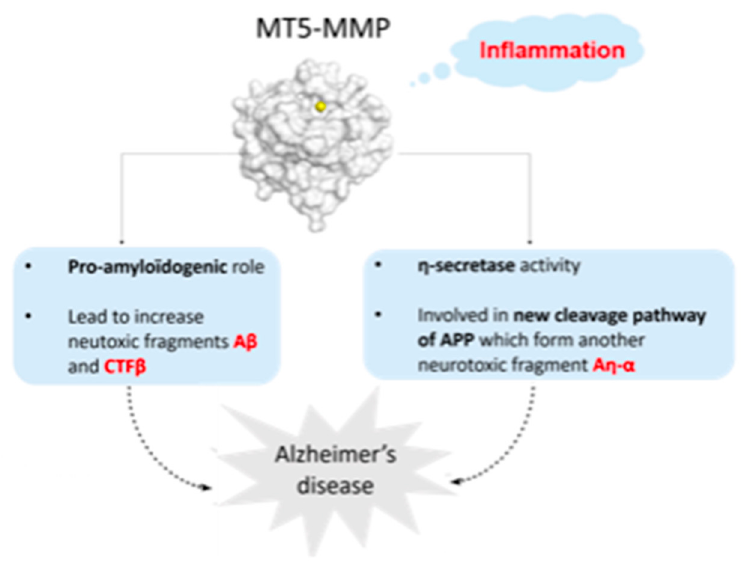
Figure 21. Presentation of MT5-MMP’s activities and APP processing [107] .